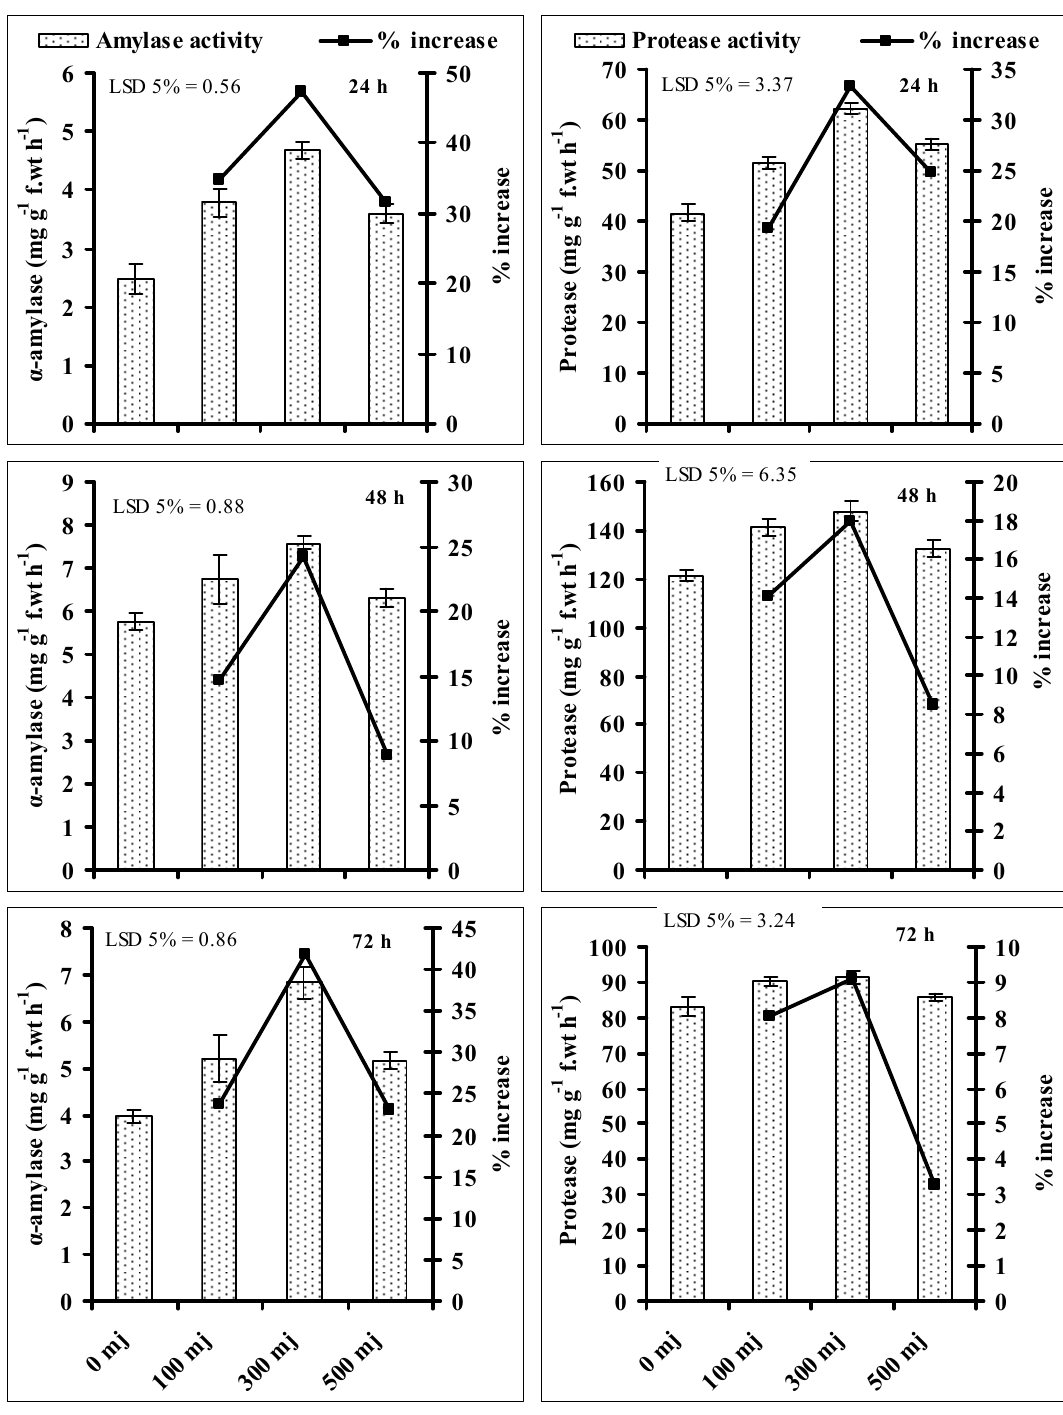
Figure 3. α -Amylase and protease activities during germination of safflower seeds irradiated with He–Ne laser of different energies (mean ± SE; n = 4).